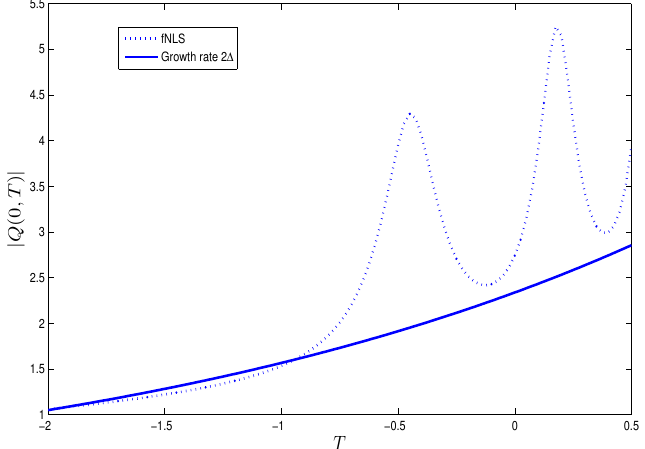
Figure 3. Case 1: | Q ( 0, T ) | when (cid:101) = 1.0, M = 1, ∆ = 0.2 with the initial condition that (10) at T 0 = − 2.